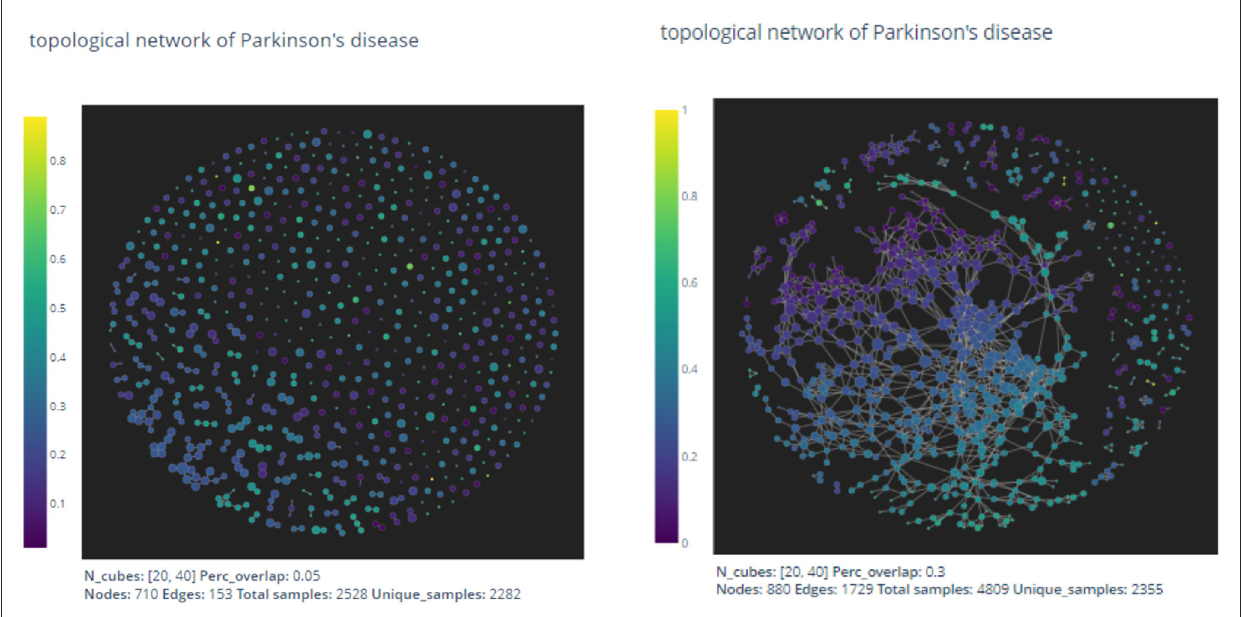
FIGURE3 The pictures are out-puts of the mapper algorithm with parameters given by n 1 = 20, n 2 = 40, p = 0.05 and n 1 = 20, n 2 = 40, p = 0.3,